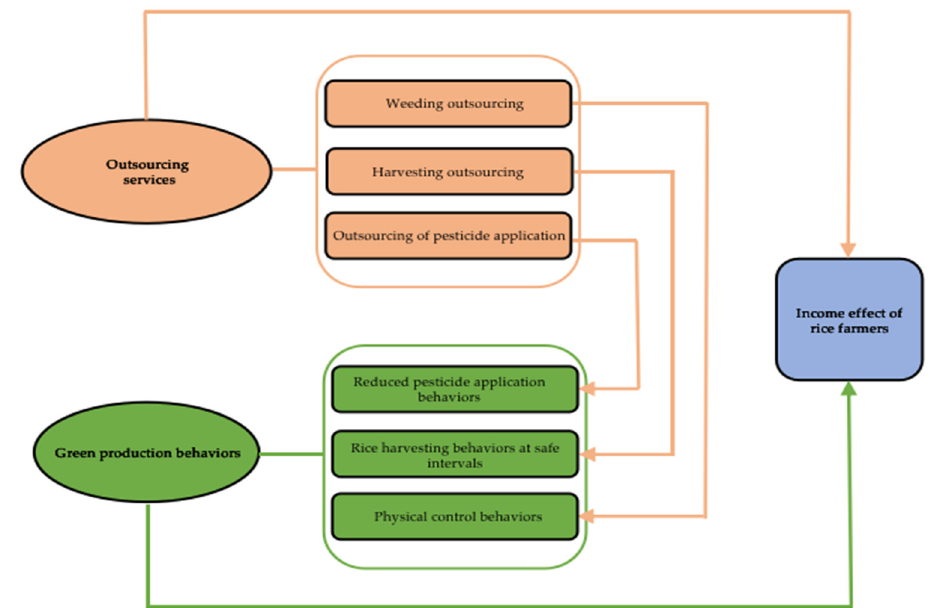
Figure 1. Theoretical model in this study.